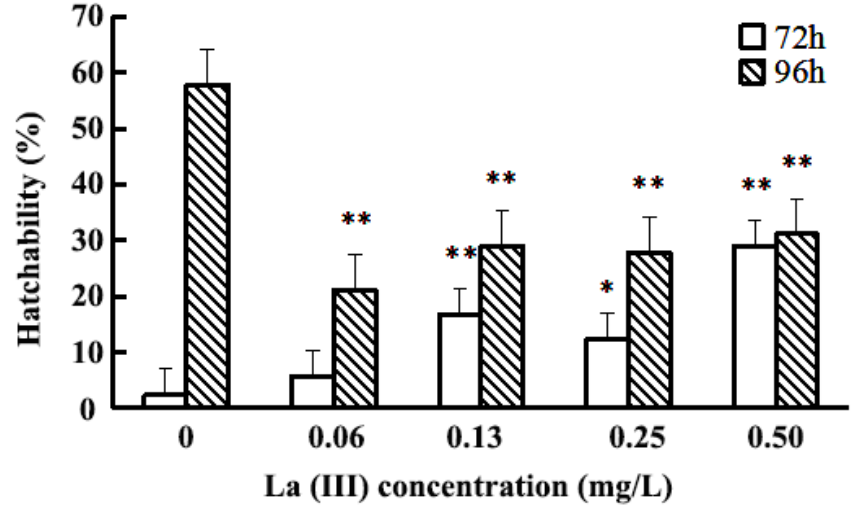
Figure 2. Effects of La (III) on hatchability of rare minnow embryos. Error bars represent standard deviation. * Significant difference from the control group ( p < 0.05) and ** highly significant difference from the control group ( p < 0.01).